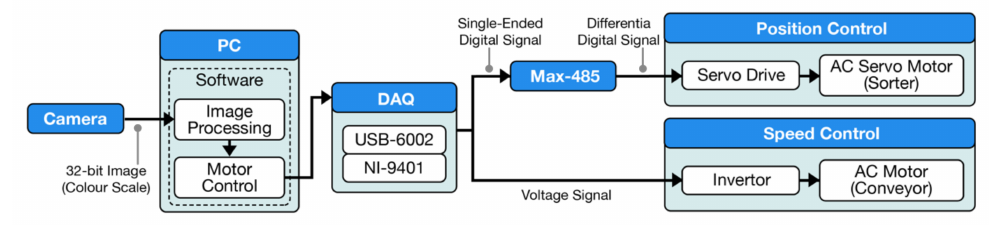
Figure 17. Schematic diagram of the fish grader for measurement and